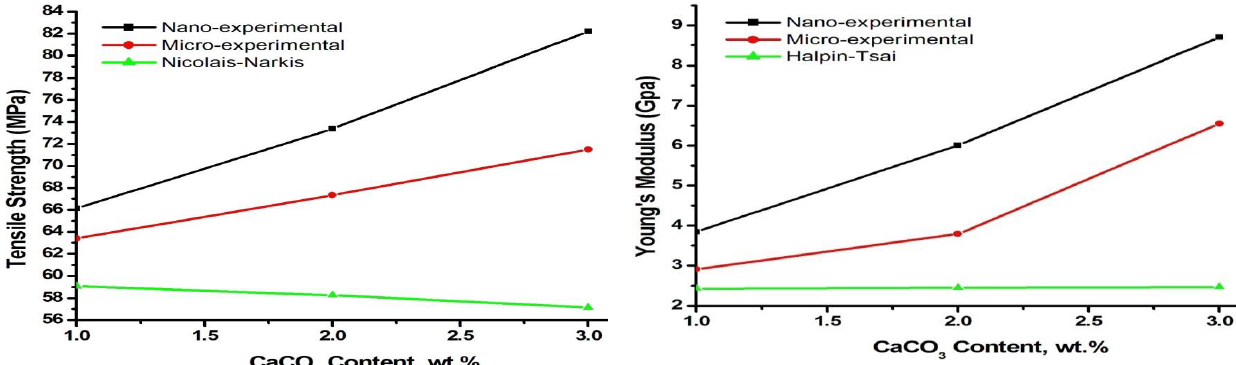
Fig.14. Comparison of predicted Young’s modulus from Halpin– Tsai equation with the experimental data.